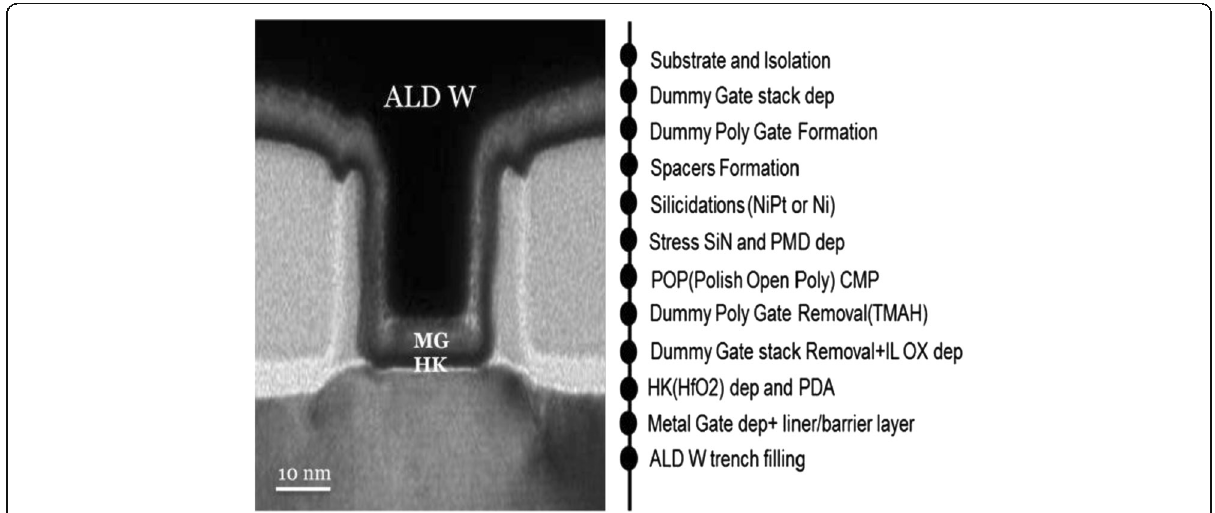
Fig. 1 The fabrication process flow of pMOSFETs using HKMG-last integration scheme. Cross-sectional scanning electron microscopy images of fabricated pMOSFETs are also